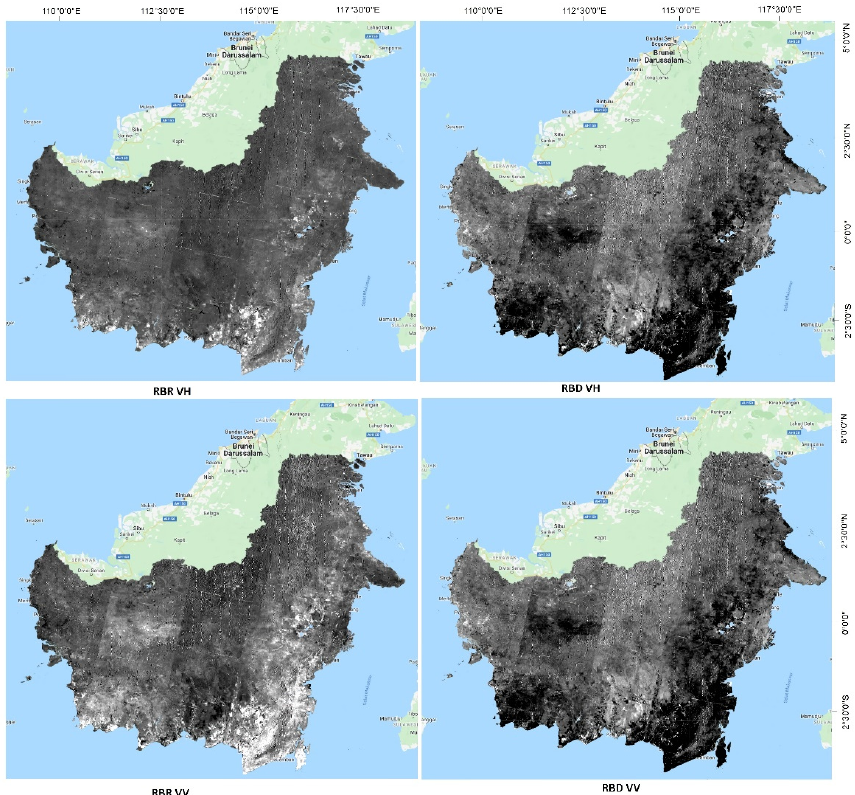
Figure 5. Cross-polarized and co-polarized radar burn ratio and radar burn difference from the Sentinel-1a SAR images.